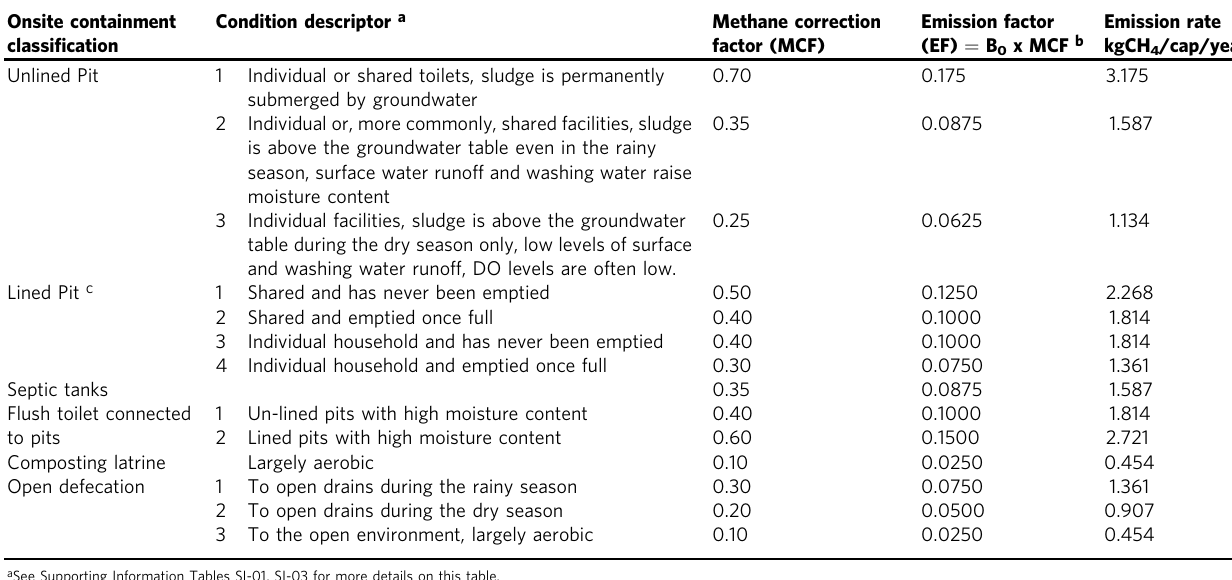
Table 2 Methane correction factors, emissions factors and per capita methane emission rates calculated for typical types of containment systems found in Kampala based on data from Nakagiri et al. 21 .